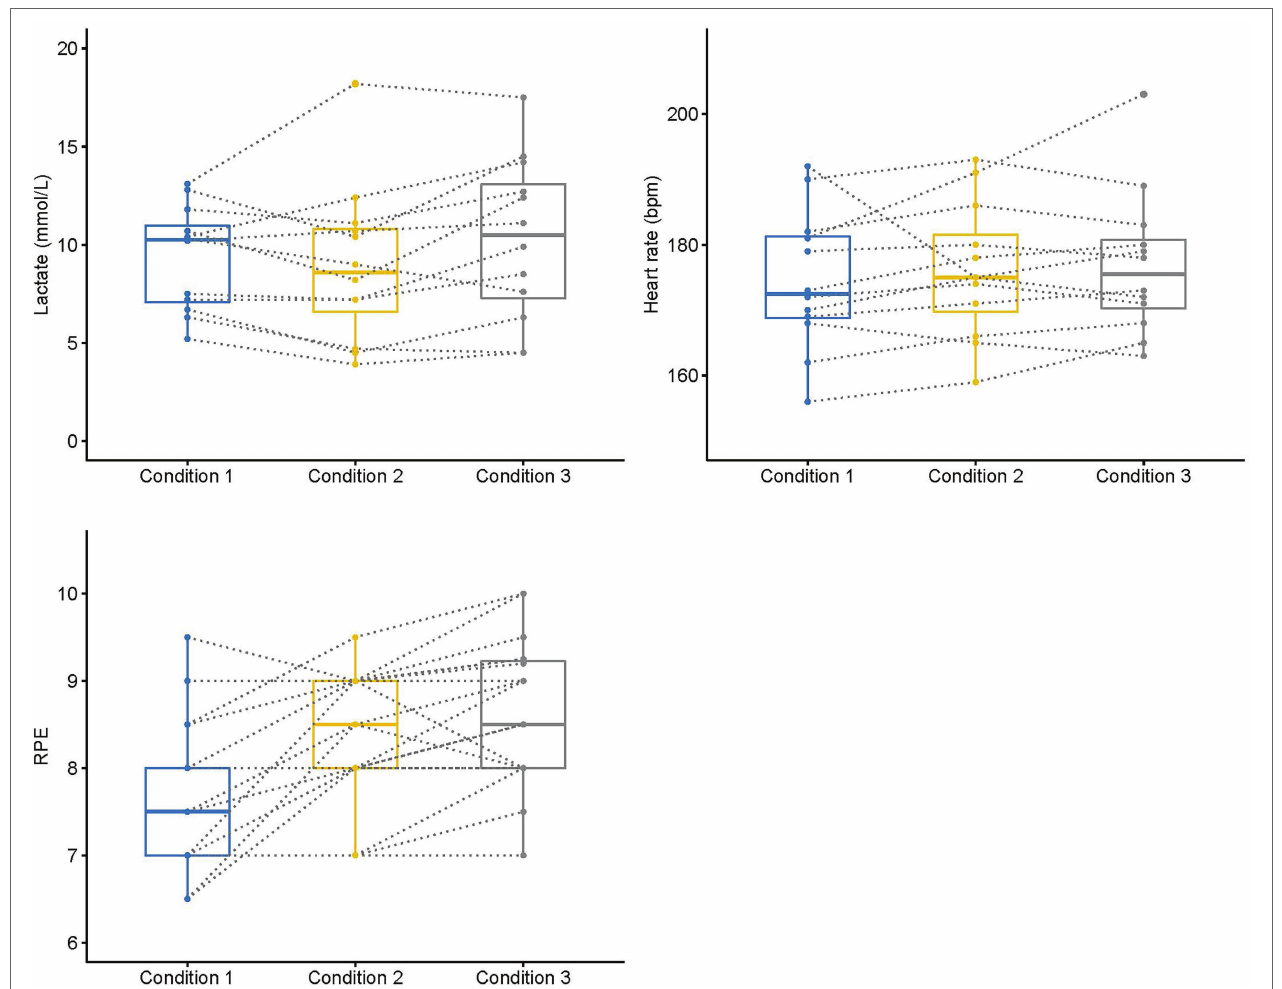
FIGURE 2 | Change of physiological parameters and perceived exertion of competitive swimmers from free (condition 1) to constrained (conditions 2 and 3) underwater swimming conditions. Box plots indicate minimum, first quartile, median, third quartile, and maximum of the data,